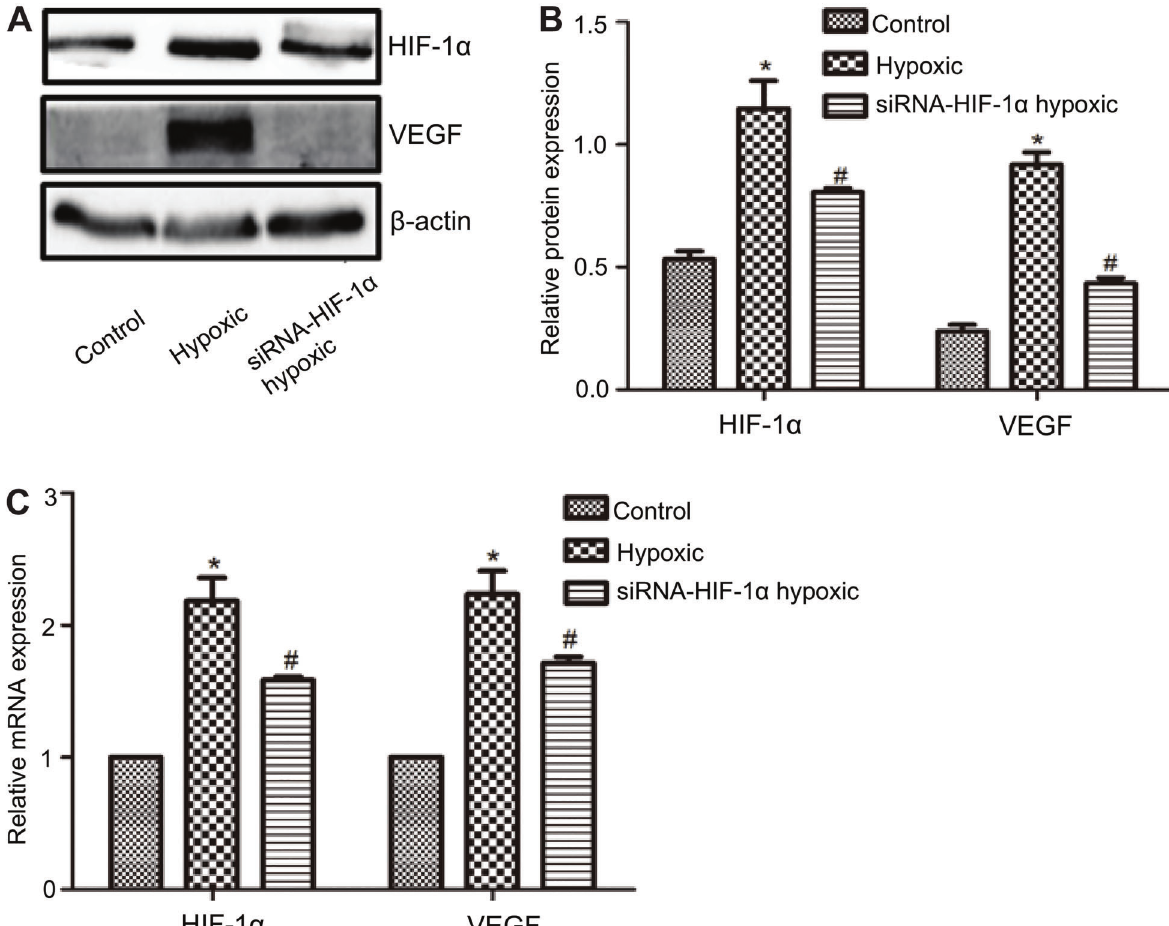
Figure 5. Effects on HIF-1 a and VEGF expression after stable transfection. A , HIF-1 a and VEGF expression. B , Histogram of HIF-1 a and VEGF protein expression. C , Histogram of HIF-1 a and VEGF mRNA expression. Data are reported as means ± SD. *P o 0.05 compared with normal control group; # P o 0.05 compared with hypoxic group